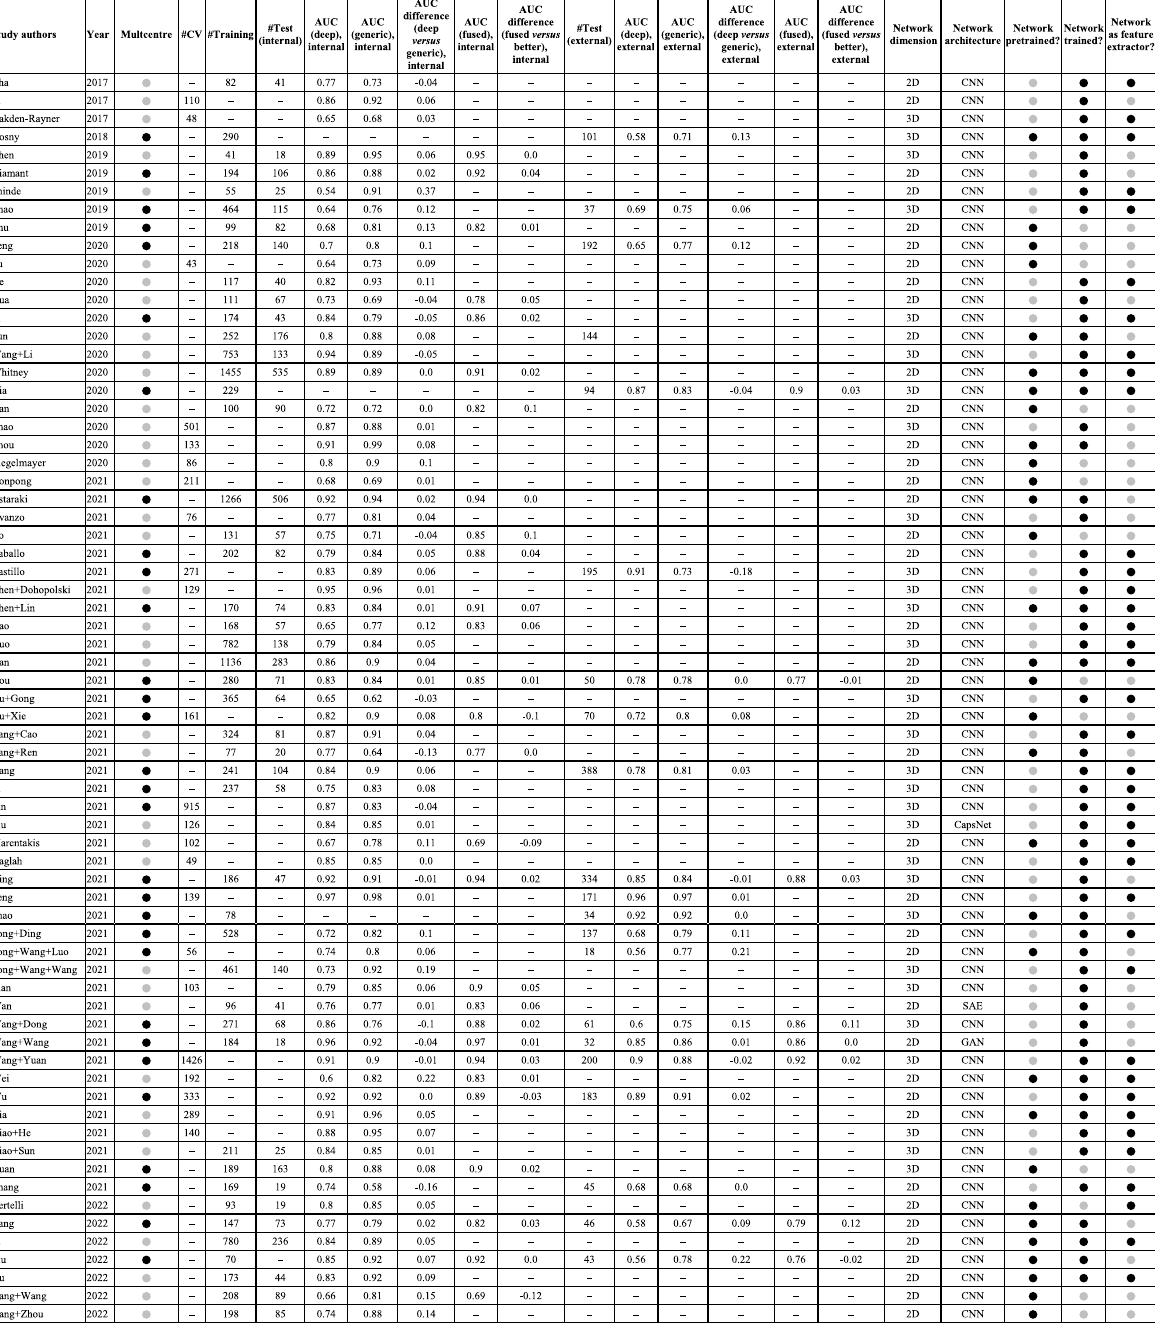
Table 2 Overview of the predictive performance reported in the included